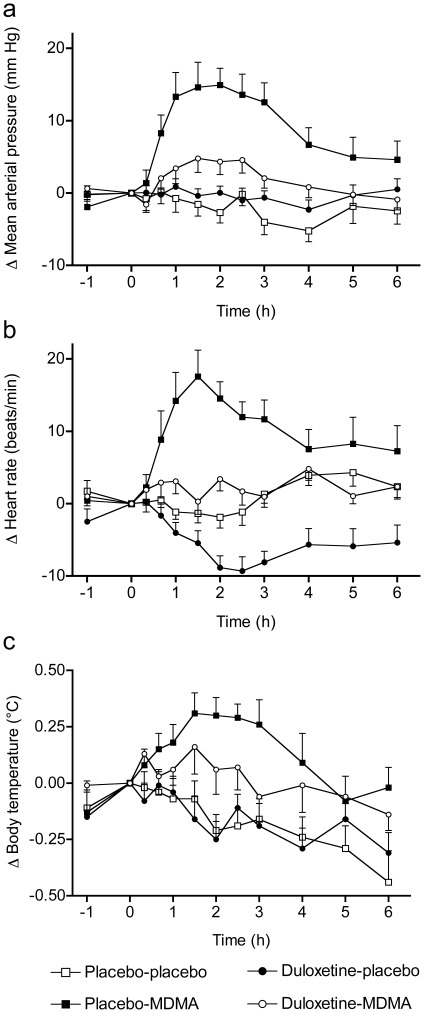
Duloxetine reduced the cardiostimulant response to MDMA.Duloxetine reduced the elevations in mean arterial blood pressure (a) and heart rate (b) in response to MDMA. Duloxetine also nonsignificantly lowered the MDMA-induced increase in body temperature (c). Values are expressed as mean+SEM of 16 subjects.